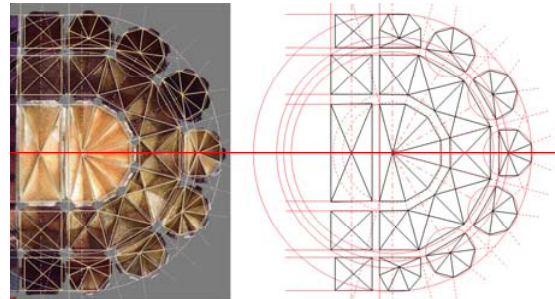
Figure 9. S. Lorenzo, Geometry from laser scanner point